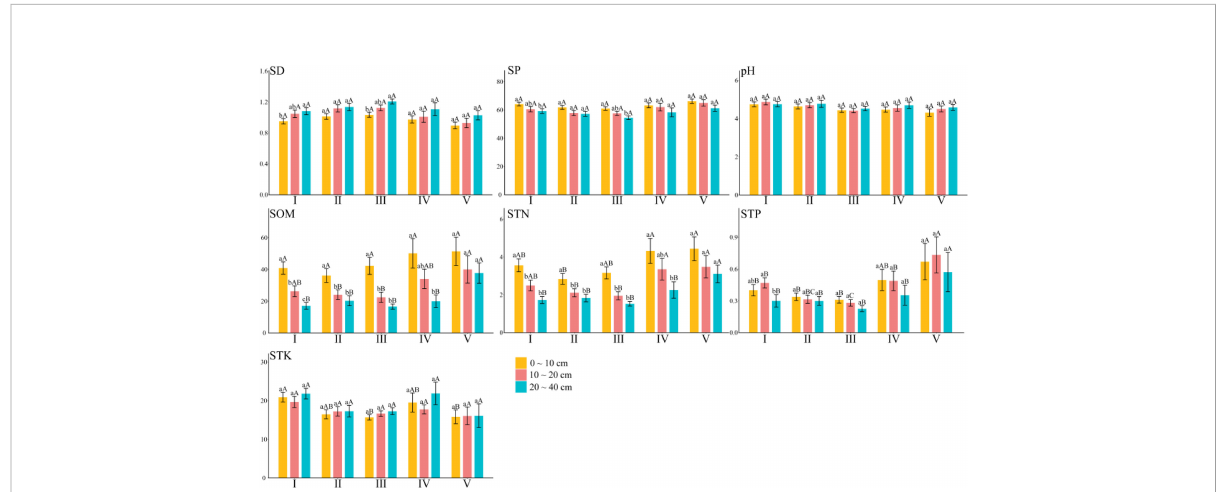
FIGURE 2 Differences of soil physical and chemical properties in different soil layers of different forest land types. SD, soil bulk density; SP, soil porosity; pH, pH value; SOM, soil organic matter; STN, soil total nitrogen; STP, soil total phosphorus; STK, soil total potassium. Above the error line, different lowercase letters indicate signi fi cant differences between different soil layers; different capital letters indicate that there are signi fi cant differences among different forest land types. I, broad-leaved forest; II; coniferous forest; III, mixed coniferous and broad-leaved forest; IV, bamboo forest; V, shrub forest. The same